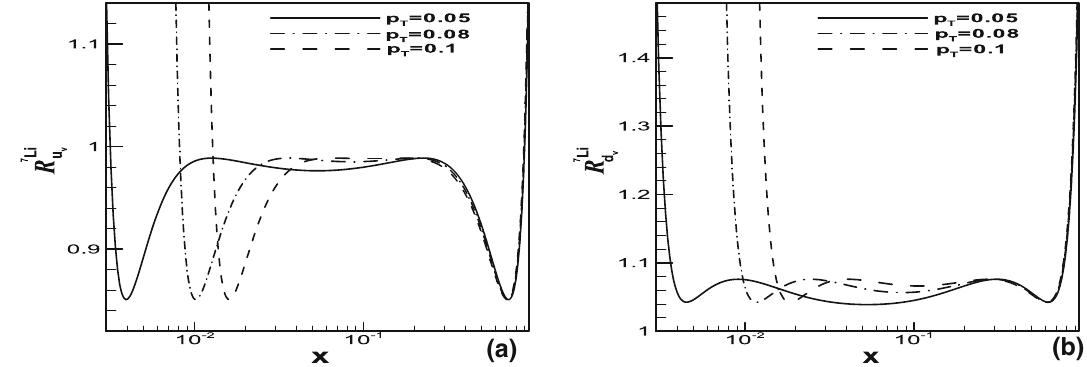
( x , p ) and b R 7 Li ( x , p ) , with respect to x at three values of p T T d v v